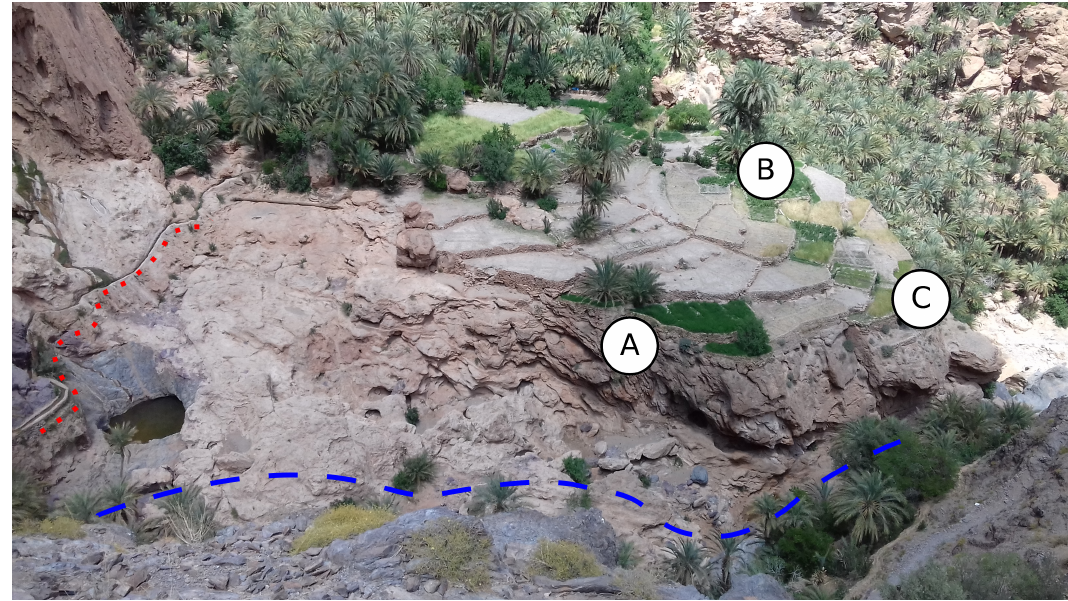
Figure 7. Overview of some plots in Assaragh TAS. Dotted red line: traditional irrigation channel. Dashed blue line: main natural wadi stream. Cultivated plots: ( A ) alfalfa, ( B ) faba bean, ( C )